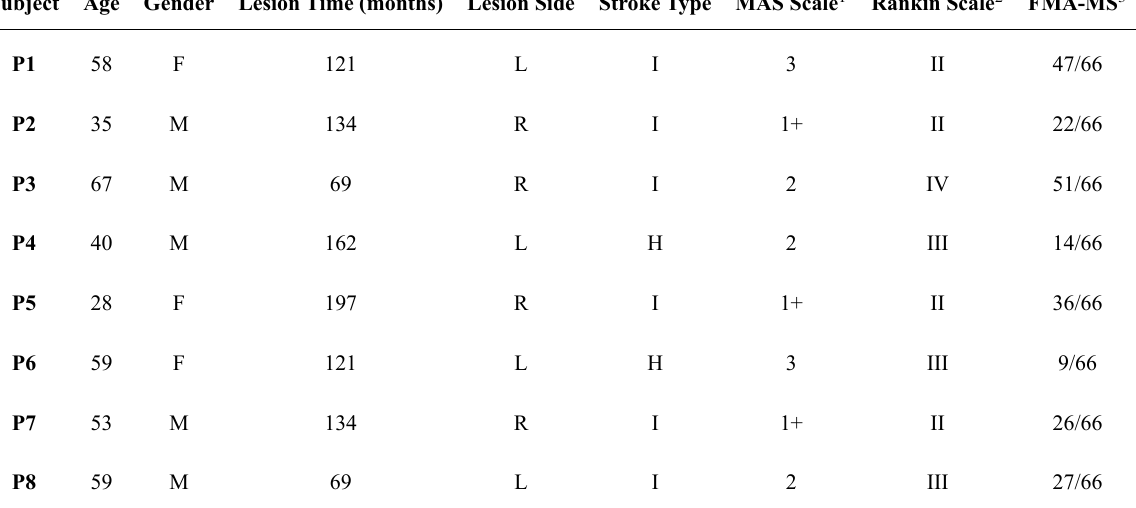
Clinical Description of the Stroke